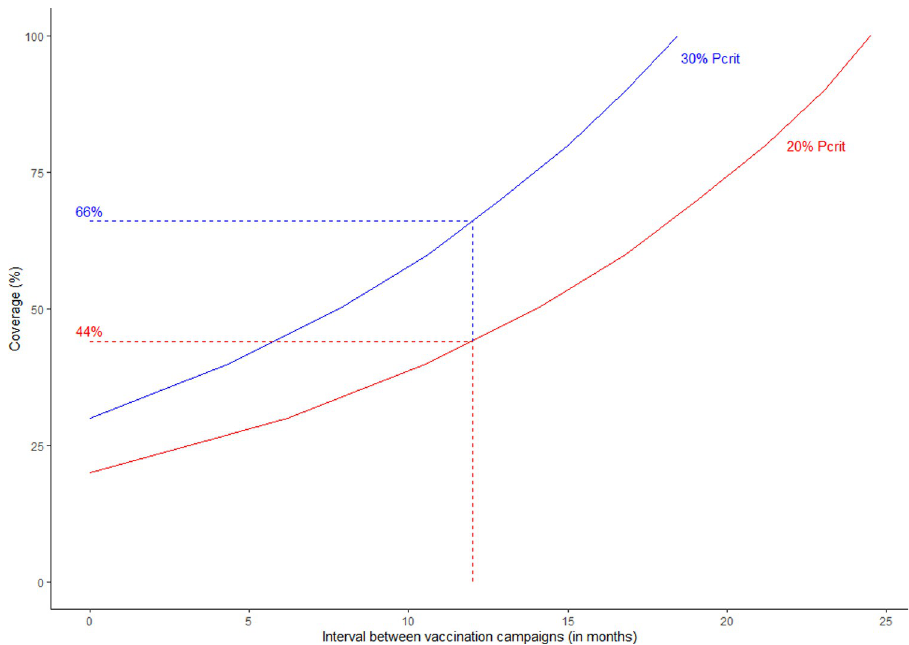
Fig 6. Required vaccination campaign intervals to prevent coverage falling to critical levels. For the populations in Tanzania, 66% coverage should maintain herd immunity above P crit of 30% for 12 months, assuming the use of high- quality vaccines (as used in this study) where the average duration of vaccine-induced immunity is 3